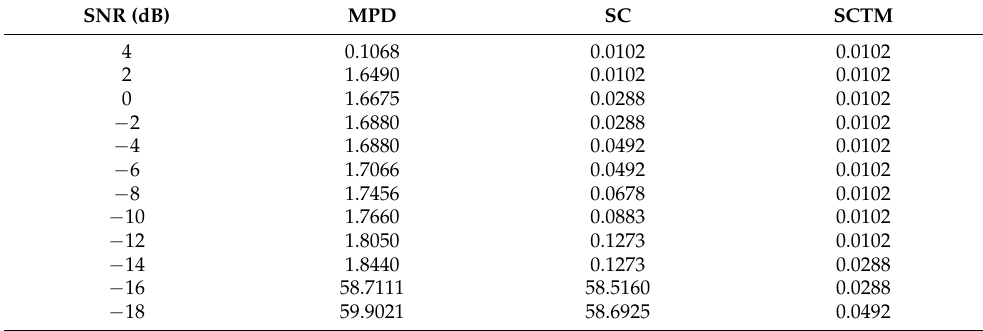
Table 4. Maximum PD estimation